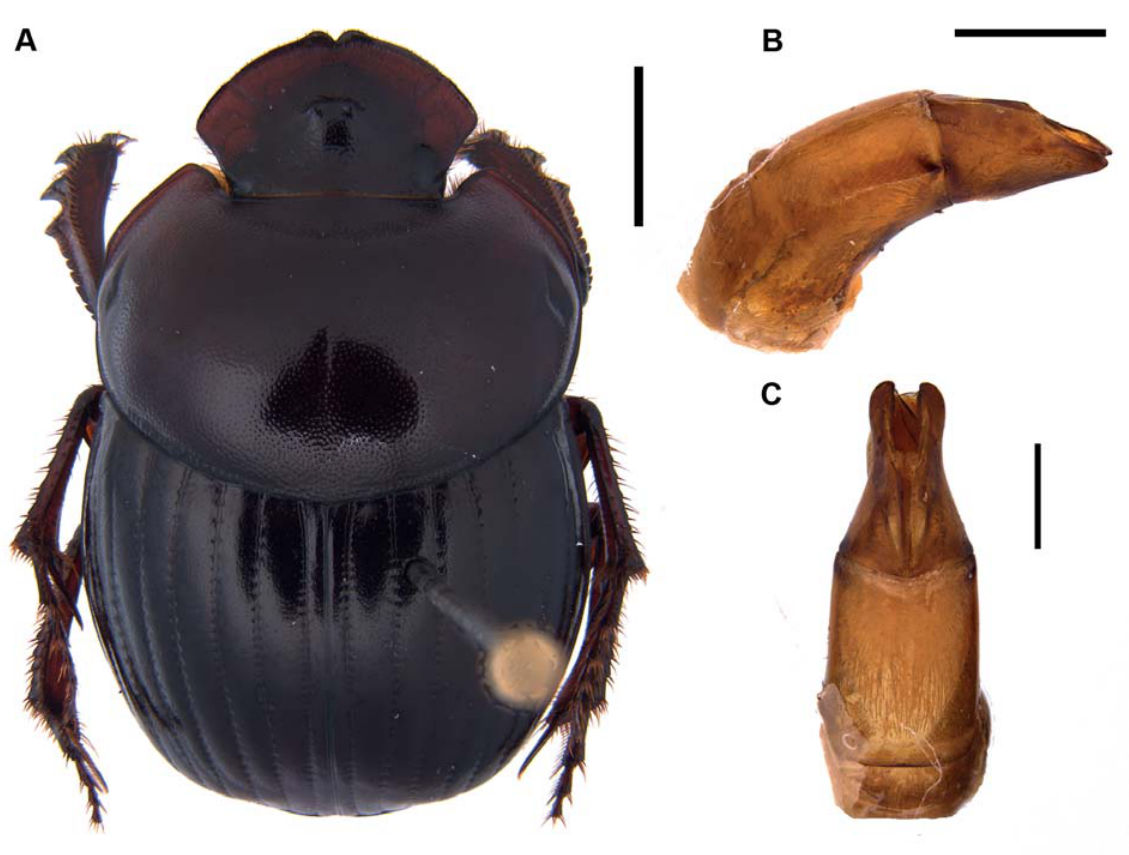
Fig. 3. Canthidium bokermanni (Martínez et al ., 1964). A . Dorsal view. B . Lateral view of aedeagus. C . Dorsal view of aedeagus. Scale bars: 1